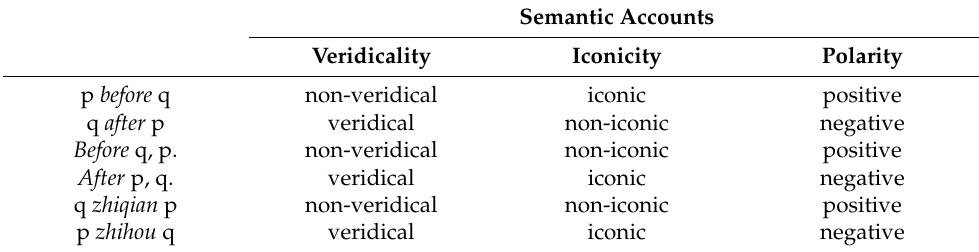
Table 1. Before and After in semantic